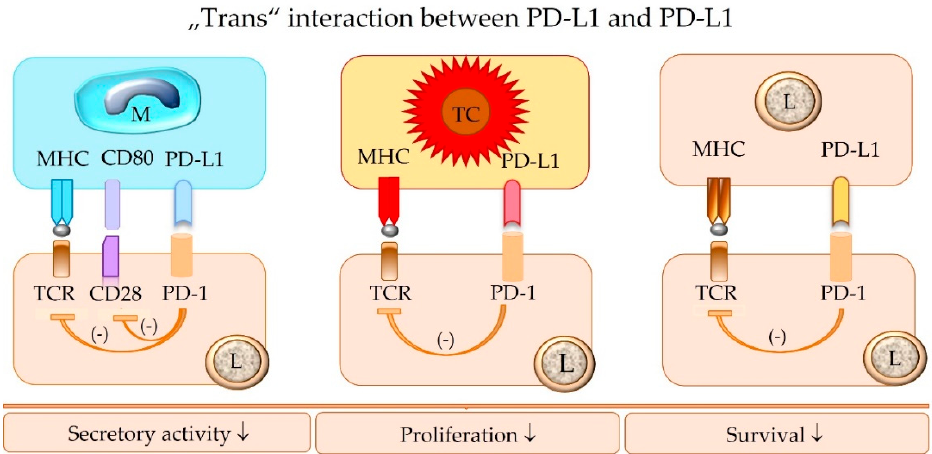
Figure 5. The “trans” interaction of PD-1 of an effector lymphocyte (L) with PD-L1 expressed by a macrophage (M), tumor cell (TC), or another lymphocyte (L) inhibits the functional activity of the PD-1-bearing target lymphocyte (L), including its survival, proliferation, and secretory activity. TCR = T cell receptor; MHC = major histocompatibility complex class I or II molecules; PD-1 = programmed cell death protein 1; PD-L1 = programmed death-ligand 1.